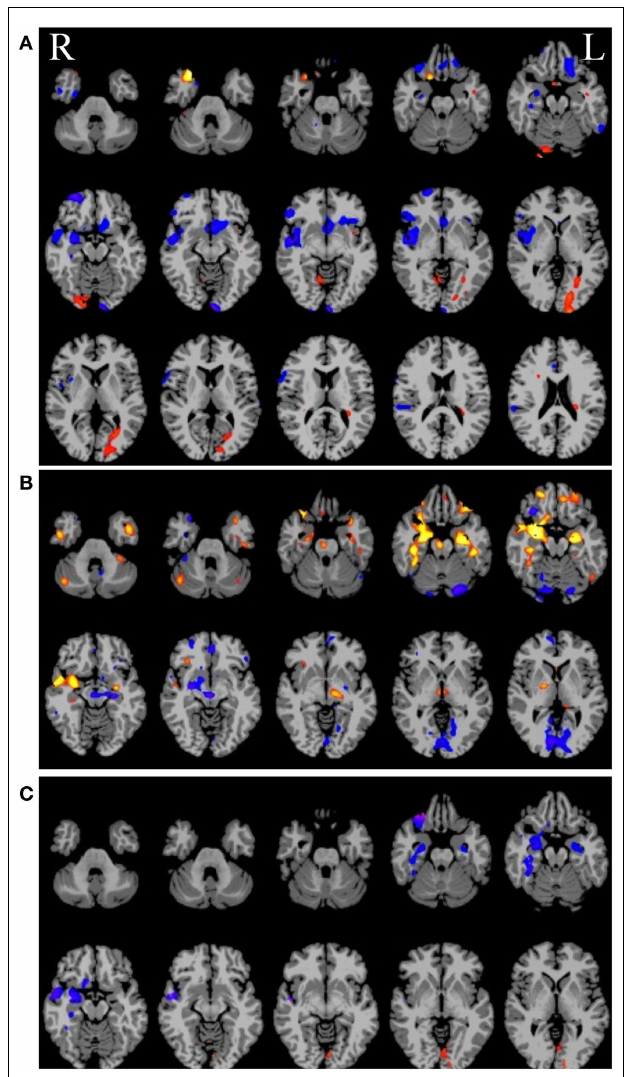
FIGURE 6 | (A) Ipsilateral connectivity for a single patient versus a group of healthy control subjects showing multiple regions with altered connectivity (warm colors = higher connectivity for patient; cool colors = higher connectivity for controls). (B) In an individual analysis of the patient data, selecting the right hippocampus, which was the onset zone suspected from clinical data, as a seed region reveals a network of nodes with high vs. low connectivity to the right hippocampus. In (C) the intersection of the maps in (A) and (B) highlights regions that have abnormal connectivity compared to controls AND are part of the same network involving the right hippocampus.